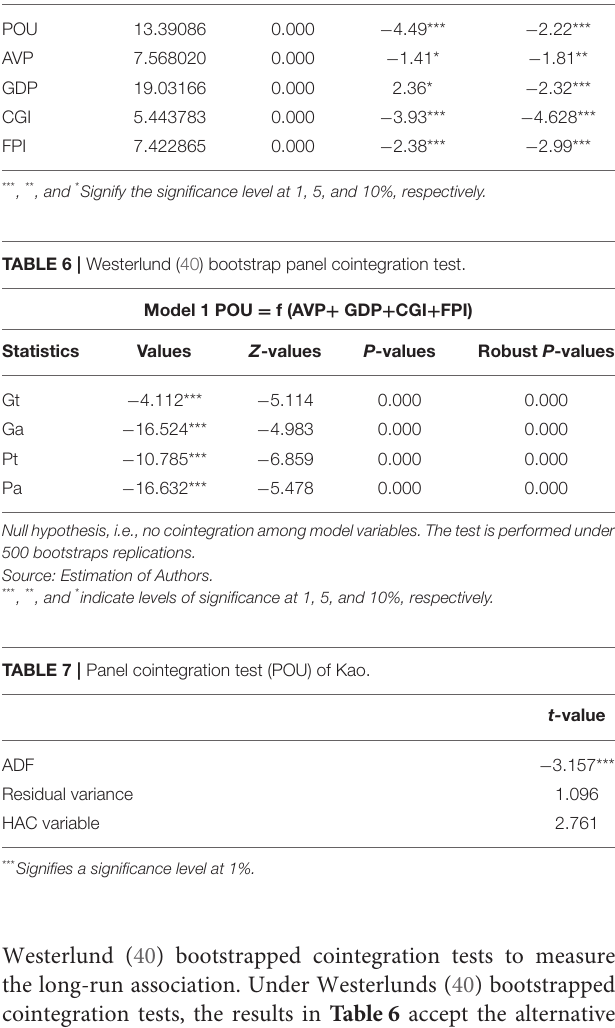
TABLE 8 | FMOLS and DOLS long run results of POU. FMOLS DOLS Variables Coefficient Std. error t -stat Coefficient Std.